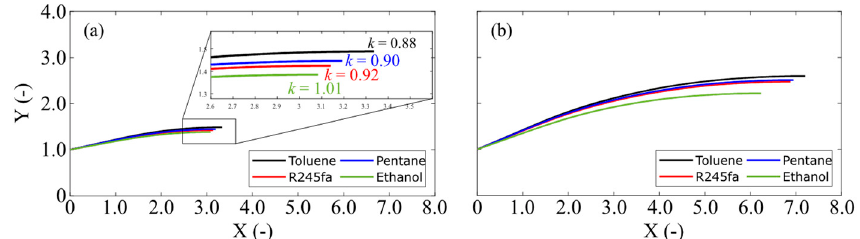
Figure 2. Upper half of nozzle divergent section from adapted MoC for several organic fluids at p 0r = 0.767, T 0r = 1.028: ( a ) target Mach number = 1.6; ( b ) target Mach number 2.0.